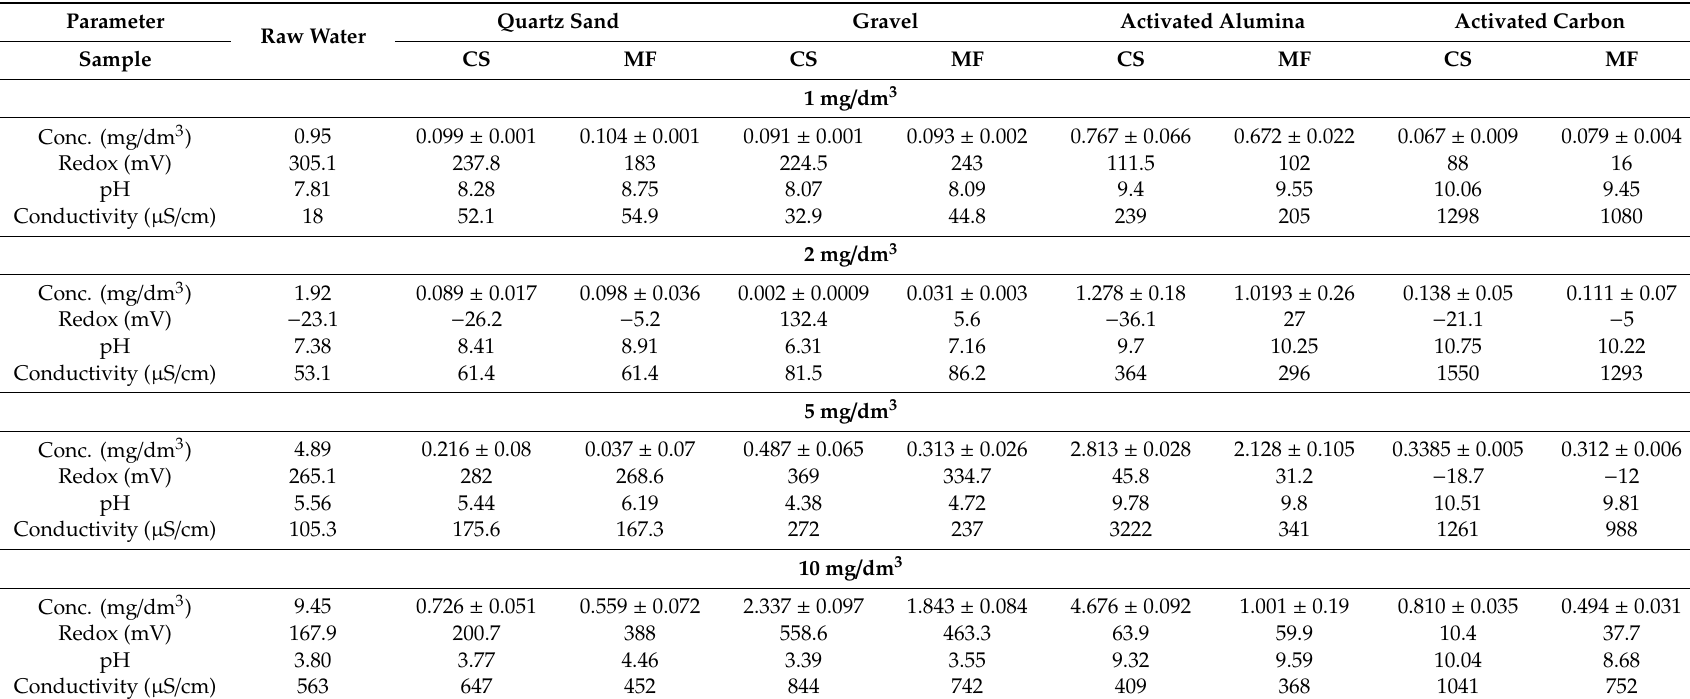
Table 3. Obtained results comparison for samples including